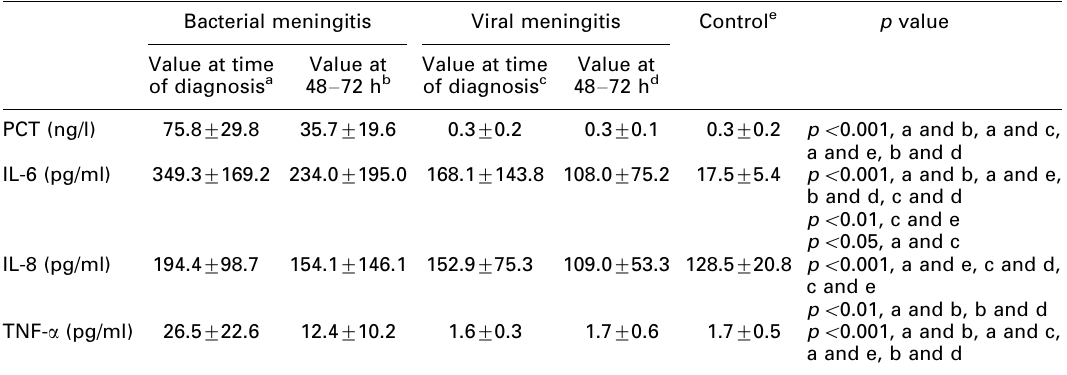
Table 3. Serum PCT and CSF cytokines values of all group Bacterial meningitis Viral